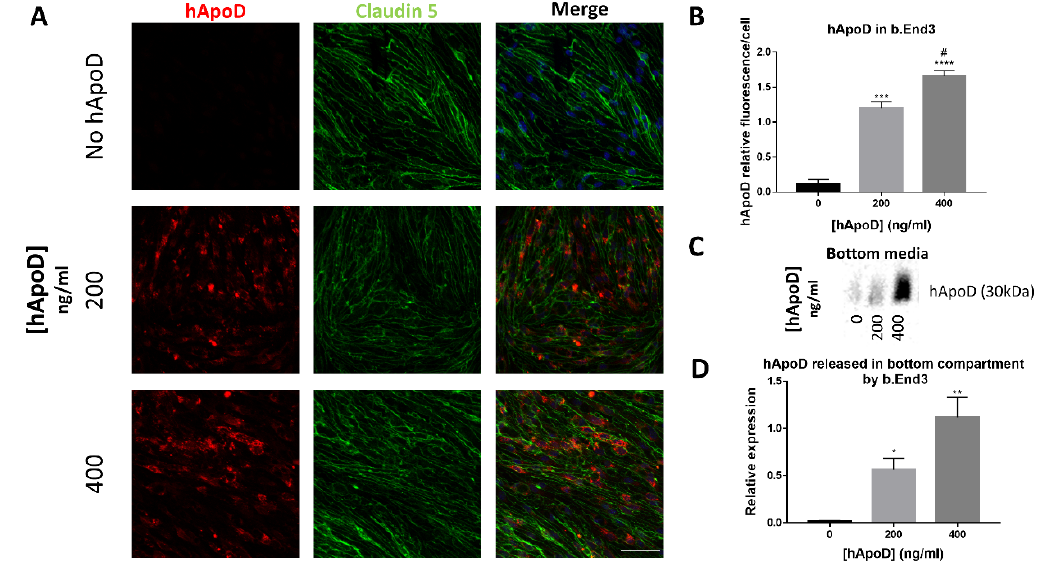
Figure 4. hApoD is subject to endocytosis and transcytosis through bEnd.3 cells. The top side of bEnd.3 cell monolayers was exposed to different concentrations of hApoD for 24 h. ( A ) Cells were immunostained for hApoD (red) and a tight junction marker (Claudin-5, green). Nuclei were stained with Hoechst (blue). Scale bar: 50 μ m. ( B ) Bottom media proteins were immunoblotted for hApoD. Representative images are shown (n = 3 independent experiments). Statistical significance for panels ( B , D ) was evaluated via a Student t -test: * p < 0.05, ** p < 0.01, *** p < 0.001, **** p < 0.0001 against the 0 ng/mL (*) and 200 ng/mL (#) conditions ( A – D ).